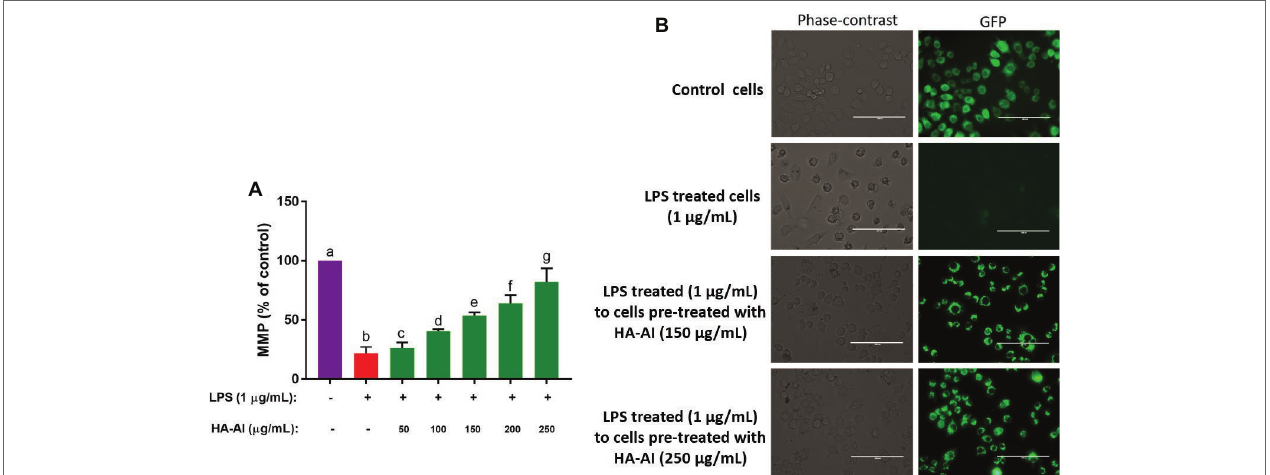
FIGURE 9 | Assessment of restoring efficacy of hydroxyapatite– A. indica (HA-AI) composite on LPS-induced depletion of mitochondrial membrane potential (MMP) in RAW 264.7 cells by rhodamine 123 staining. (A) Dose-dependent restoring efficacy of HA-AI composite on LPS-induced depletion of MMP. (B) Phase contrast and fluorescent microscopic images depicting the restoring efficacy of HA-AI composite on LPS-induced depletion of MMP. The scale bar is 100 μm. The experiments were performed individually in six replicates and achieved results were stated as mean ± standard deviation. The data were statistically evaluated by one-way ANOVA following Tukey’s post hoc multiple comparison test. The statistical variance among the experimental groups was measured as significant at p < 0.05. The columns with different alphabets were significant within the respective study.